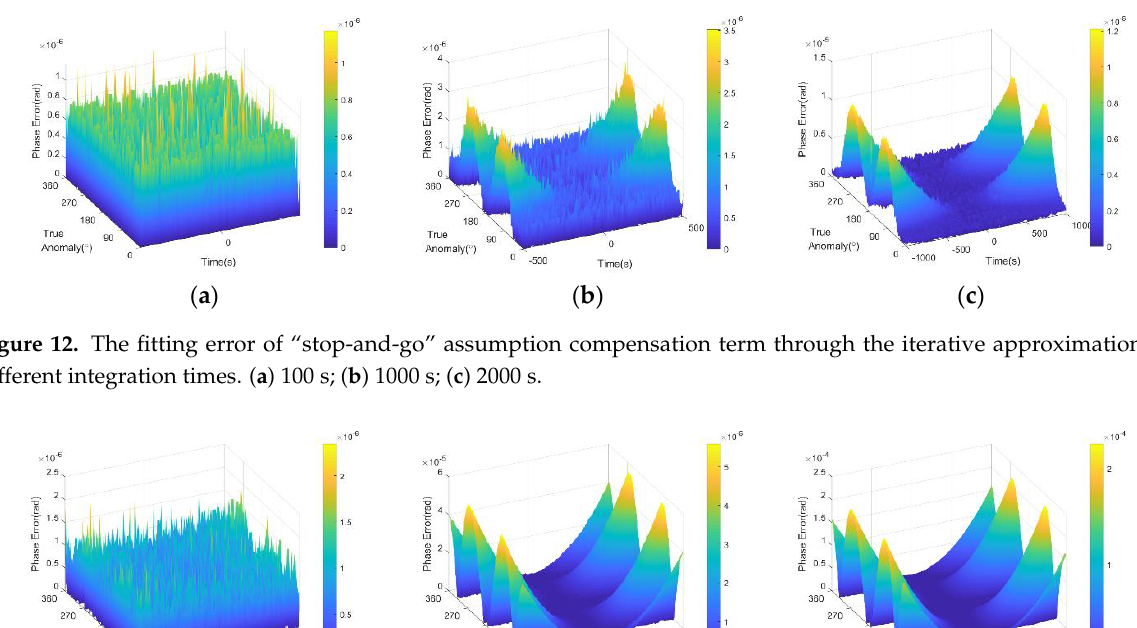
Figure 13. The fitting error of the “stop-and-go” assumption compensation term by the proposed method in this paper for